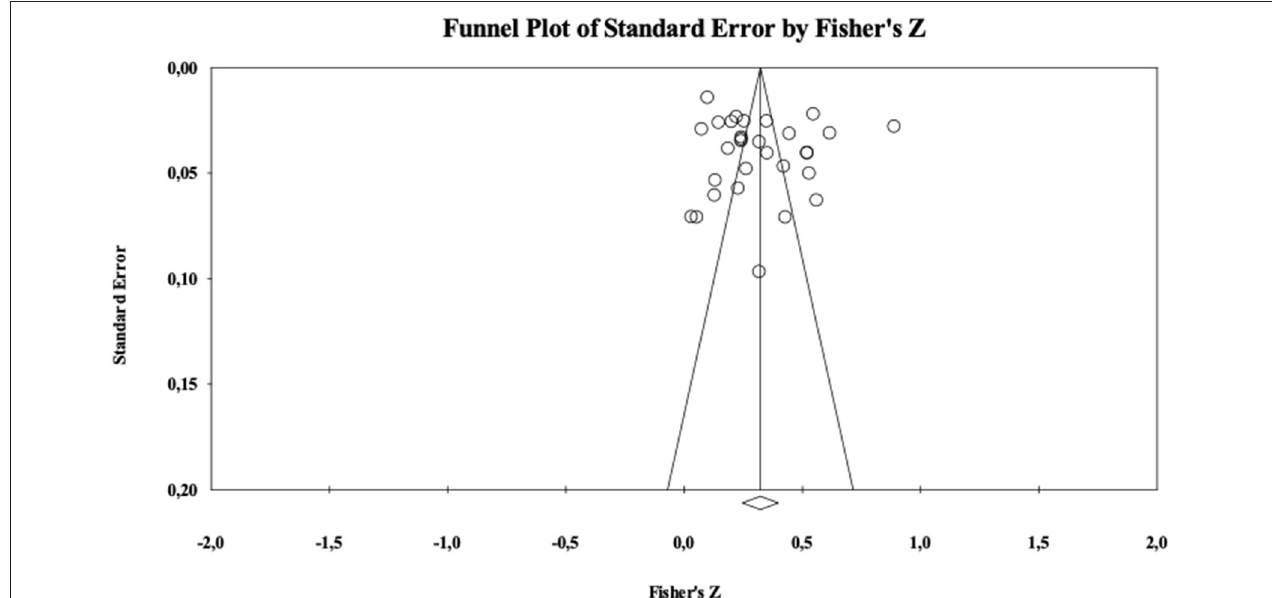
FIGURE 6 | Funnel plot for awareness.